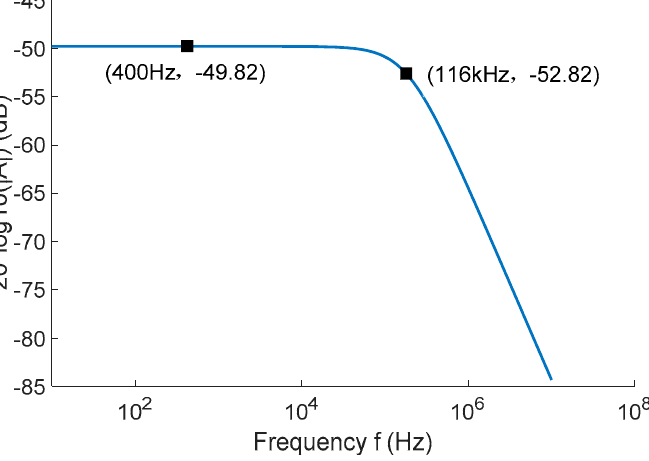
Figure 12. TMR low-frequency current sensor simulation frequency characteristic curve.